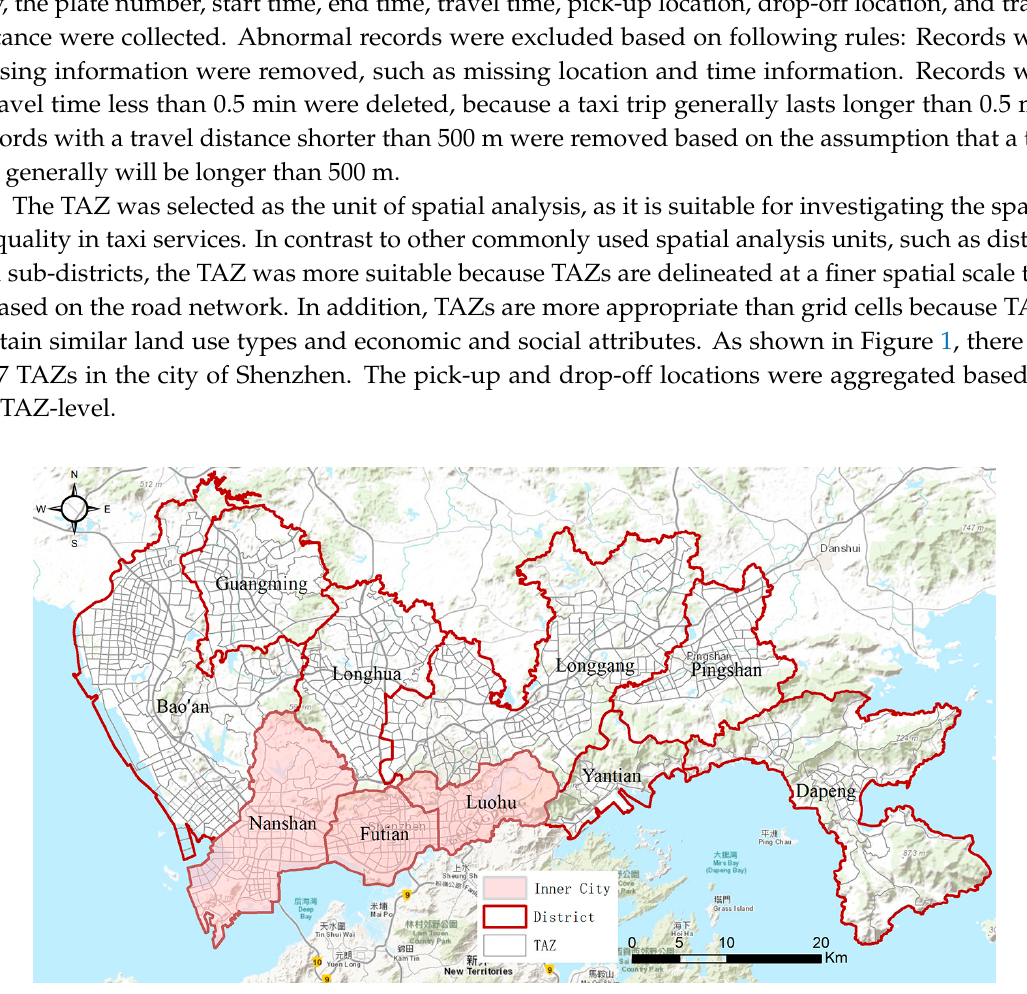
Figure 1. The administrative districts and traffic analysis zones (TAZs) of Shenzhen city.